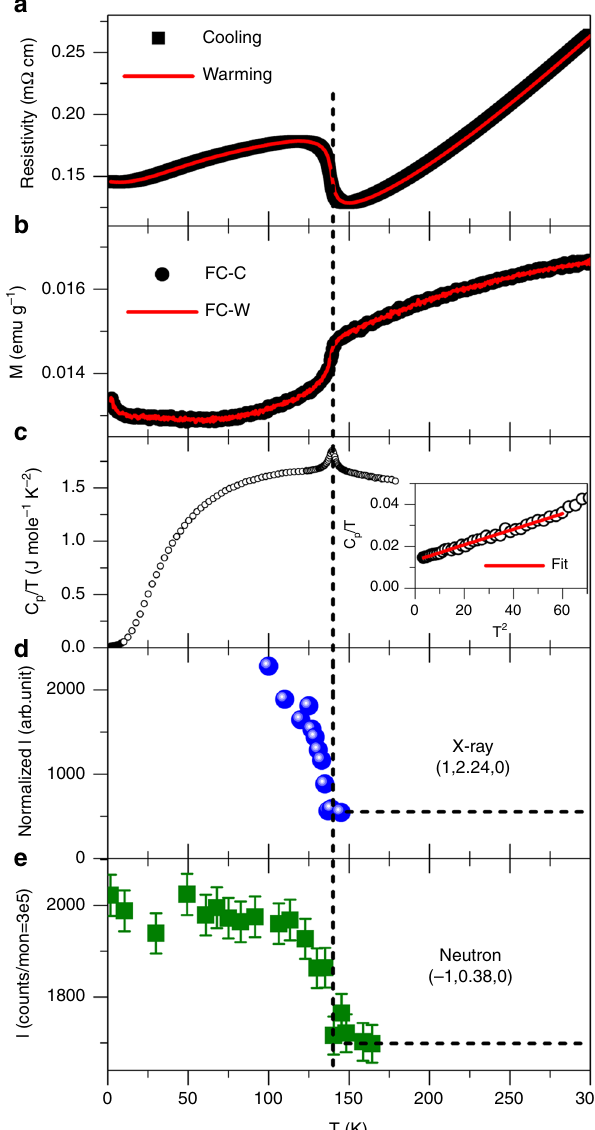
Fig. 1 Physical properties and order parameter of La 4 Ni 3 O 10 . ab-plane ( a ), resistivity in zero fi eld and ( b ), magnetic susceptibility measured under 0.4 T upon cooling and warming. c Heat capacity. Inset shows fi t to low temperature data. d Temperature dependence of integrated intensity at (1, 2.24, 0) measured with x-rays. e Temperature dependence of integrated intensity at ( − 1, 0.38, 0) measured with neutrons. Error bars represent one standard